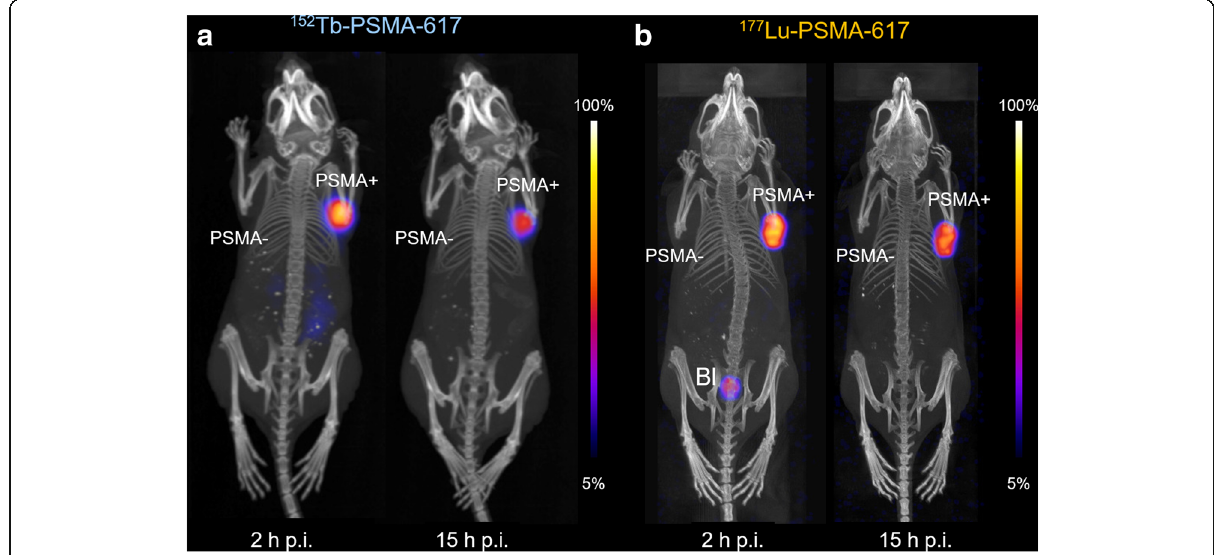
Fig. 2 Nuclear images of PC-3 PIP/flu tumor-bearing mice at 2 h and 15 h post injection of a 152 Tb-PSMA-617 (PET/CT) and b 177 Lu-PSMA-617 (SPECT/CT). PSMA+, PSMA-positive PC-3 PIP tumor; PSMA-, PSMA-negative PC-3 flu tumor; Bl, urinary